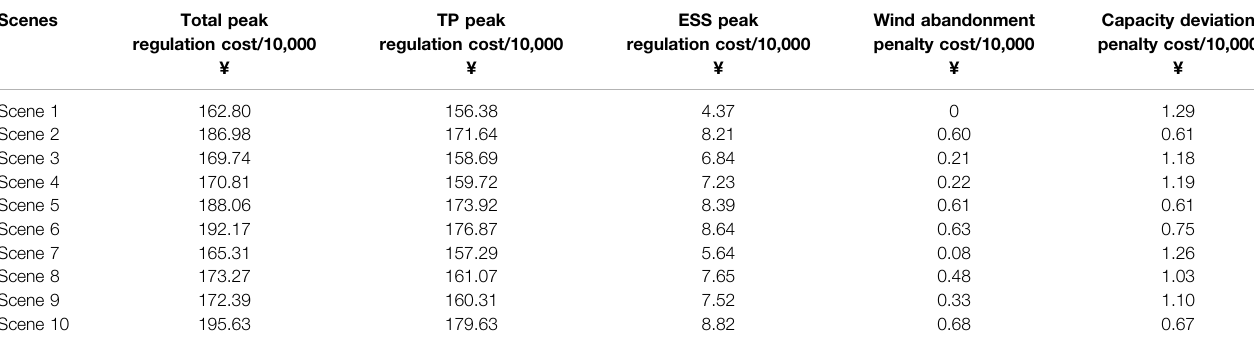
TABLE 5 | System peak regulation results in different